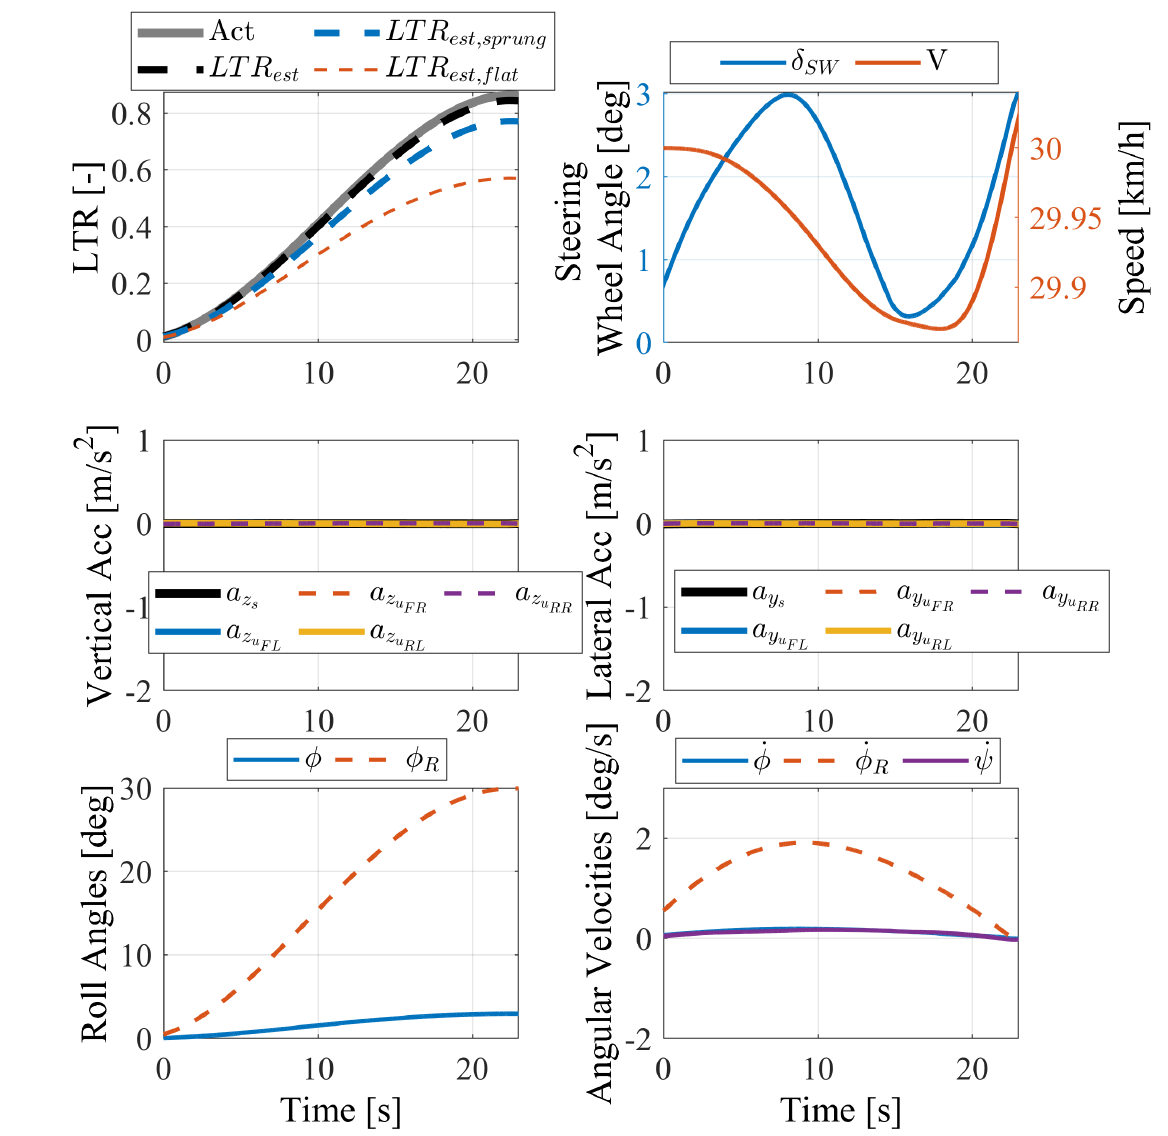
Figure 4. Straight manoeuvre at 30km/h on a banked road. From the top left side to the down right side: LTR , steering wheel angle and vehicle speed, vertical accelerations, lateral accelerations, roll angles and angular